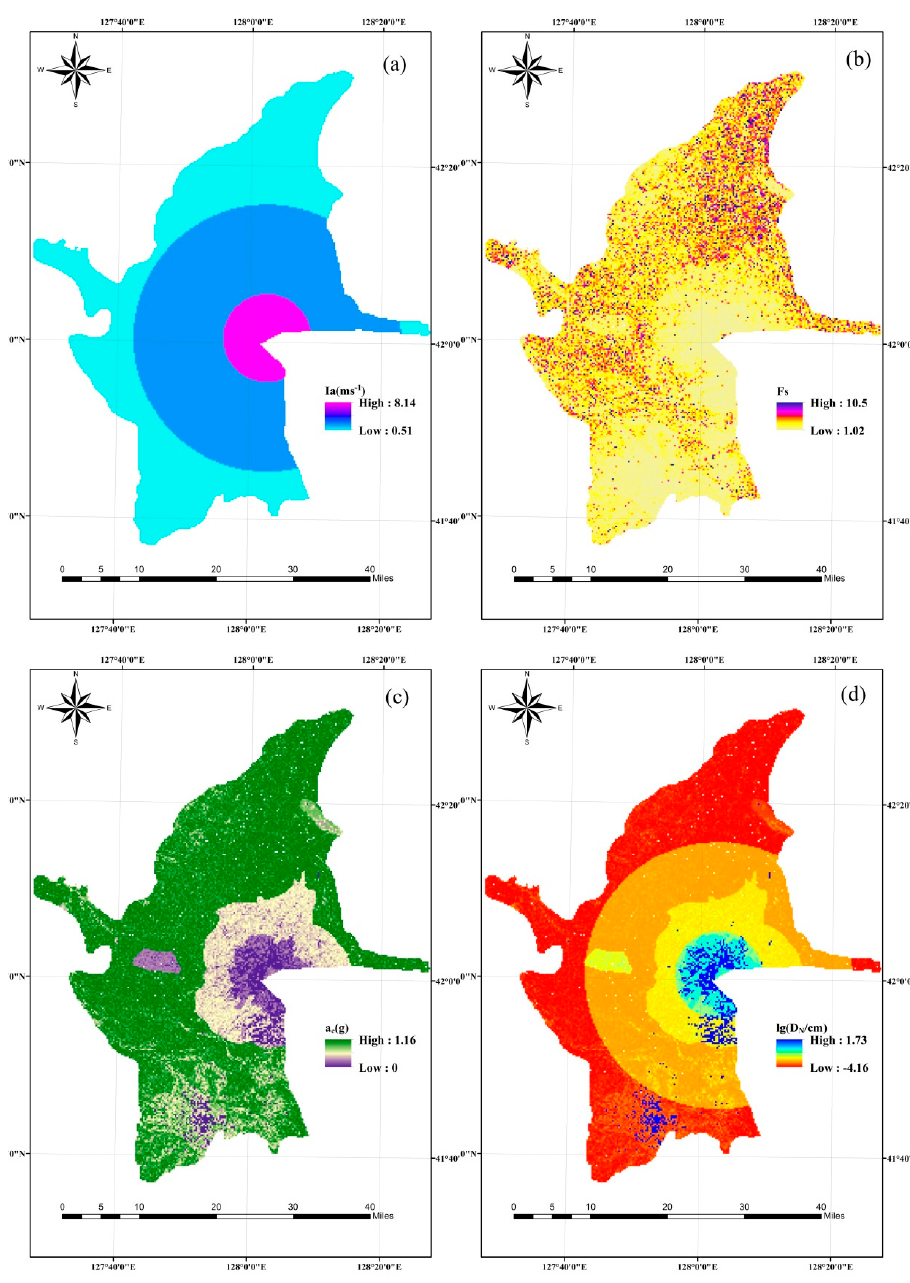
Figure 5. Condition parameters: ( a ) Arias intensity, ( b ) static safety factor, ( c ) critical acceleration, and ( d ) cumulative displacement. ( d ) cumulative